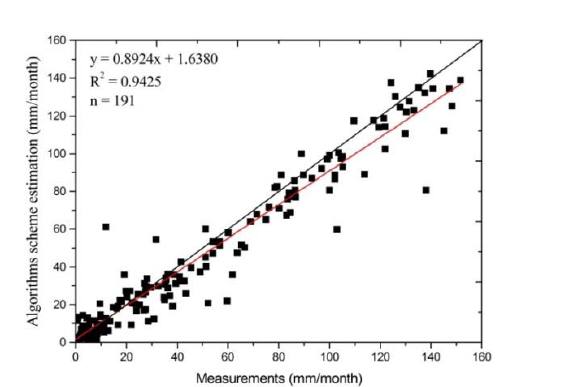
Figure 7. Estimated monthly ET from the proposed algorithms and observed eddy covariance (EC) at 6 sites in the upper, middle, and downstream reaches of the Heihe River Basin from 2008 to 2014.